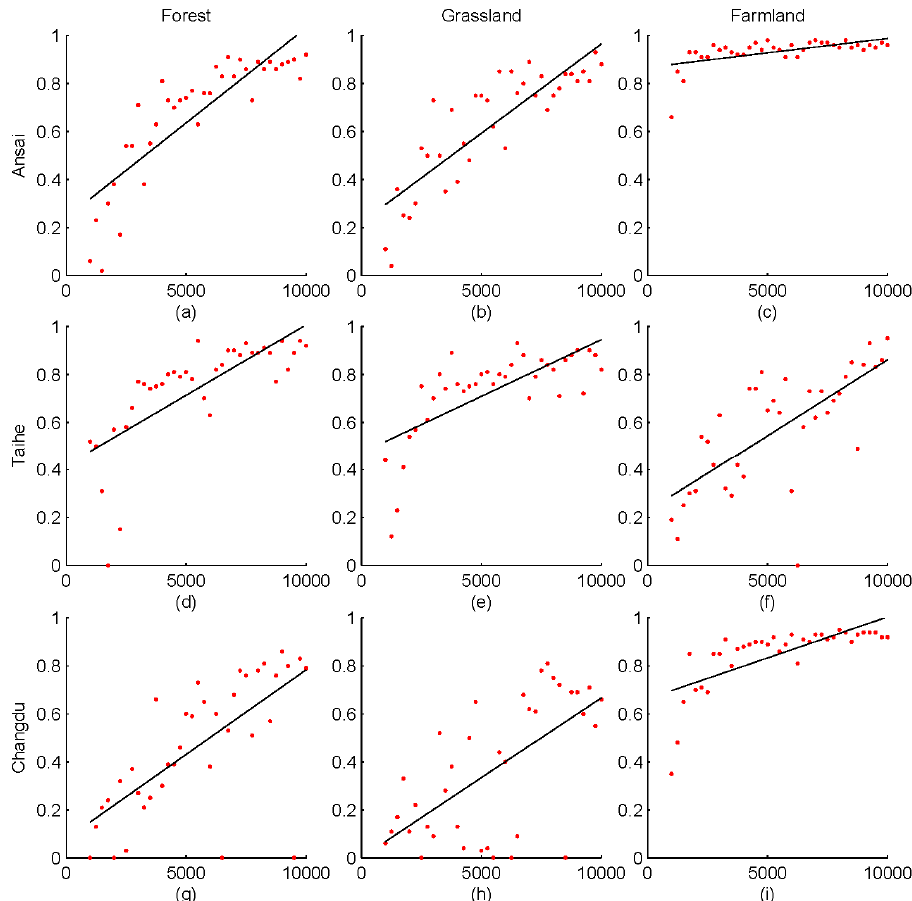
Figure 8. Relationship between sample size ( SS ) and R 2 for Ansai’s forest ( a ), grassland ( b ), farmland ( c ), Taihe’s forest ( d ), grassland ( e ), farmland ( f ), and Changdu’s forest ( g ), grassland ( h ), farmland ( i ); the x -axis is SS and the y -axis is R 2 .